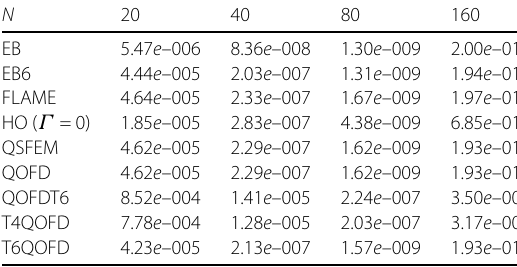
Table 3 Errors of different sixth-order schemes ( k =